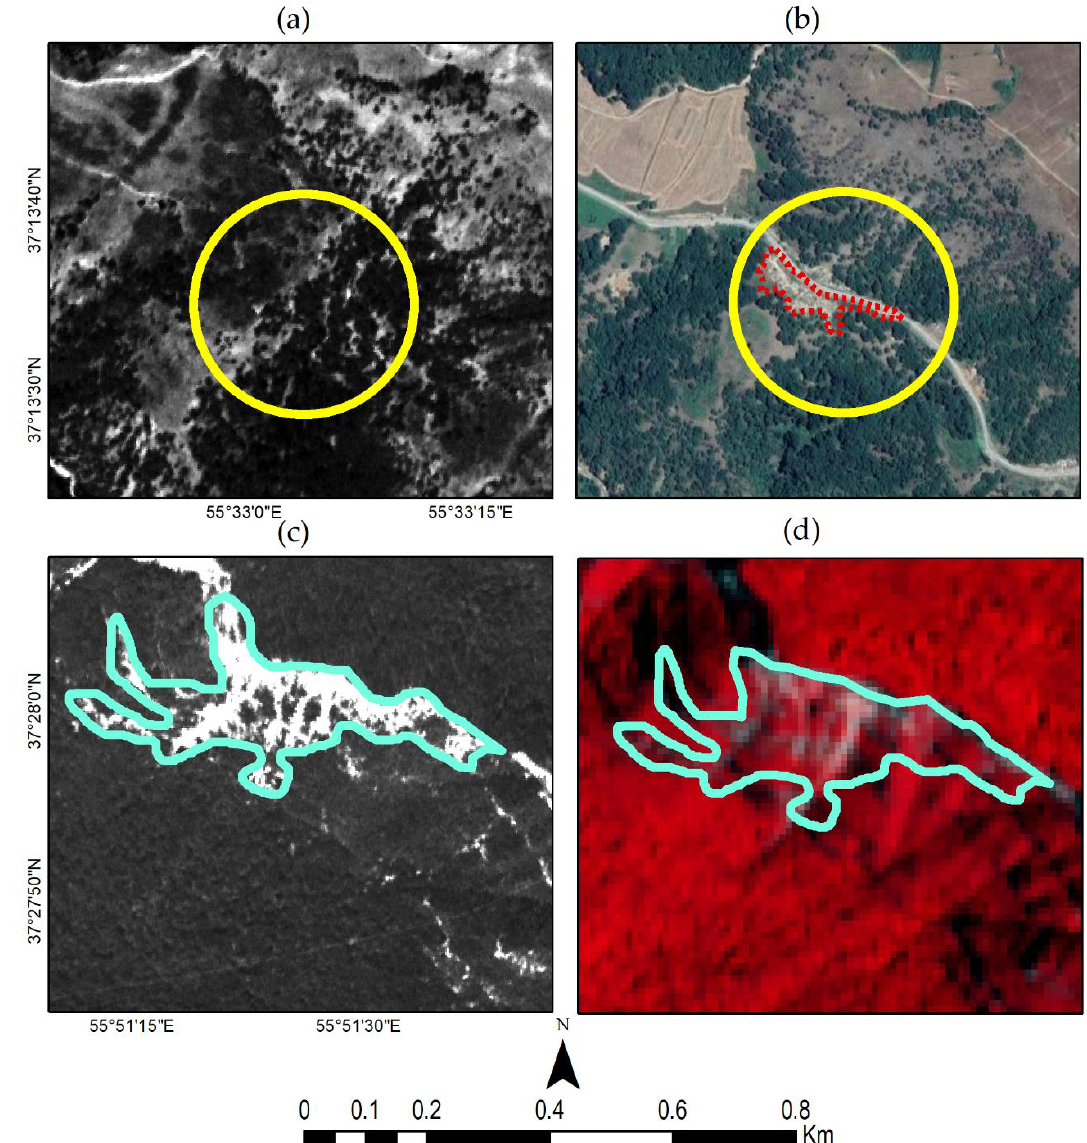
Figure 2. Samples of historical landslides in the study areas: A new landslide sample that has detected on the Google Earth image in a part of the non-protected forests in 2016 ( b ); while it was not affected by the landslide in 1970 based on the CORONA image ( a ); an old sample of a landslide which was detectable in both images of CORONA (1970) ( c ); and Sentinel-2A (2016) ( d ); in the protected forests, NE Iran.